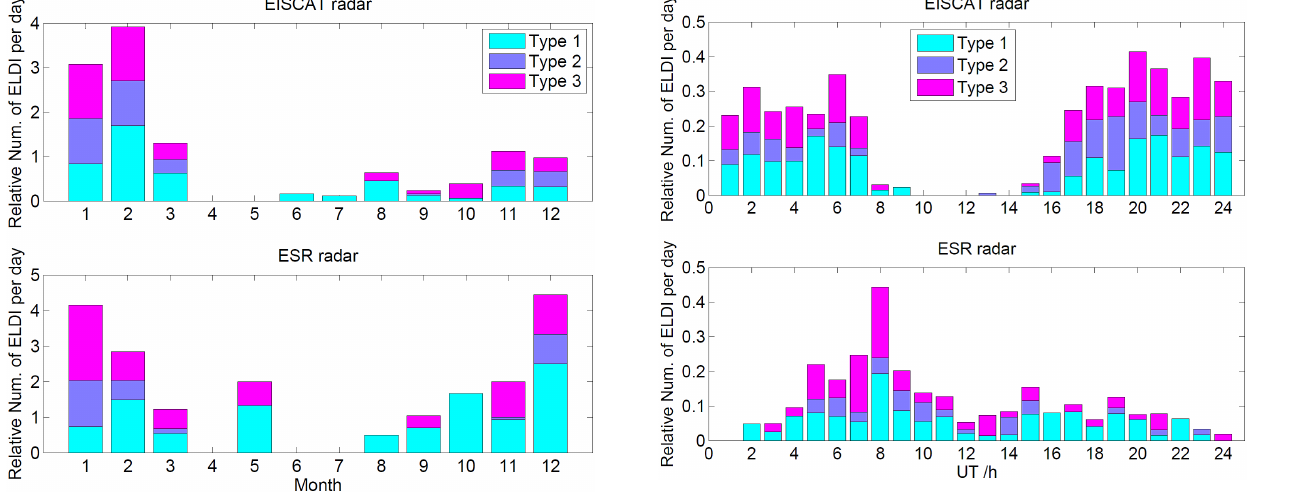
Figure 11. Diurnal variation of various types of ELDIs at EISCAT/ESR sites during 2009–2011 (LT ≈ UT + 1h, MLT ≈ UT + 3h). Table 2. Average N m F 2 and N m E during the period of presence and absence of ELDI observed by EISCAT/ESR